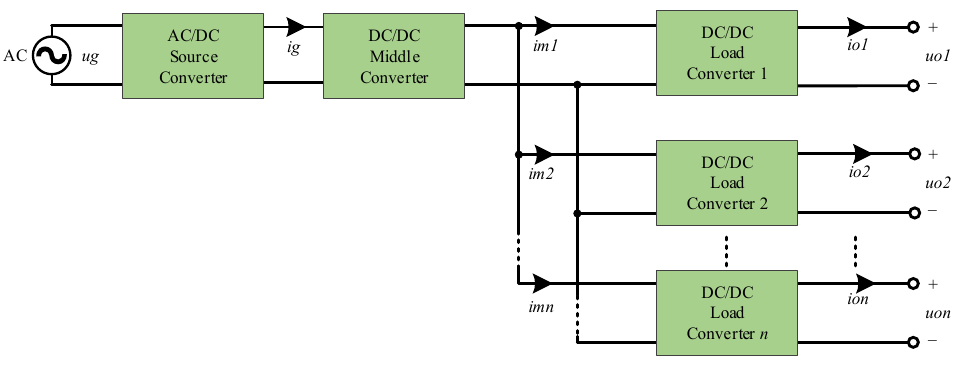
Figure 1. Intermediate bus power architecture.